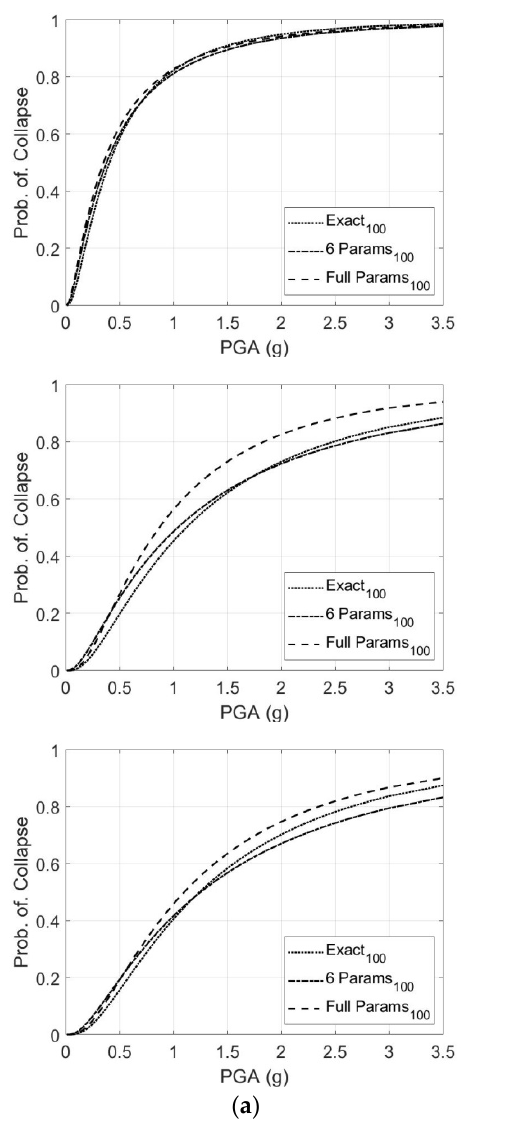
Figure 7. Fragility curves using 13-floor structure for ( a ) 100 sampling size with IO (upper left), LS (center left), and CP (lower left) levels; and ( b ) 400 sampling size with IO (upper right), LS (center right), and CP (lower right)